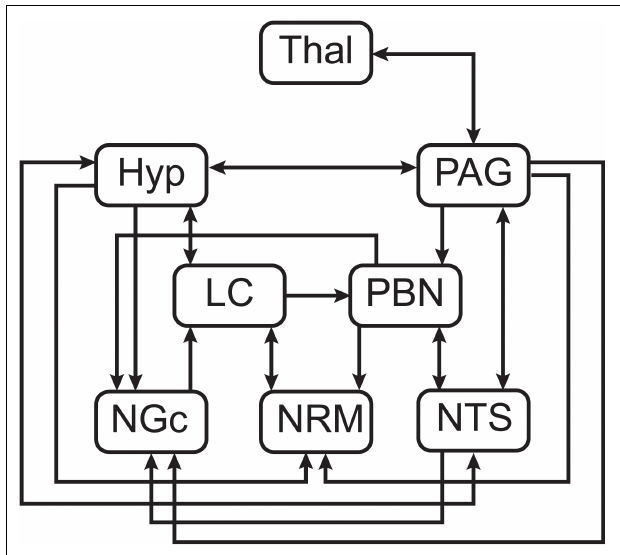
FIGURE 2 | Pre-defined anatomical model of connections between brainstem regions of